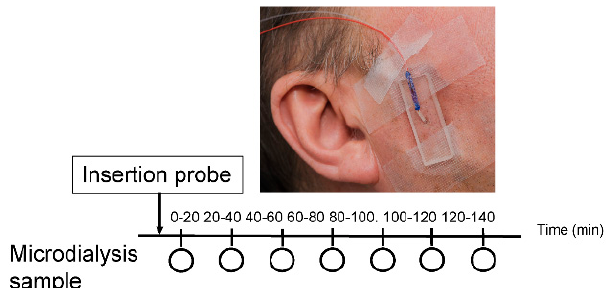
Figure 1. A schematic illustration of the study design. The circle represents every 20 min for sample collection (20, 40, 60, 80, 100, 120 and 140 min). The time point 20 to 100 min indicates the trauma phase and time point 100-120 min indicates the stabilization phase. Intramuscular microdialysis was performed on the right masseter muscle. The microdialysis probe (Ø 0.5 mm; membrane length 10 mm; molecular cut-off: 6 kDa) was inserted into the muscle and perfused at a rate of 5 µ L/min with a Ringer-acetate solution.